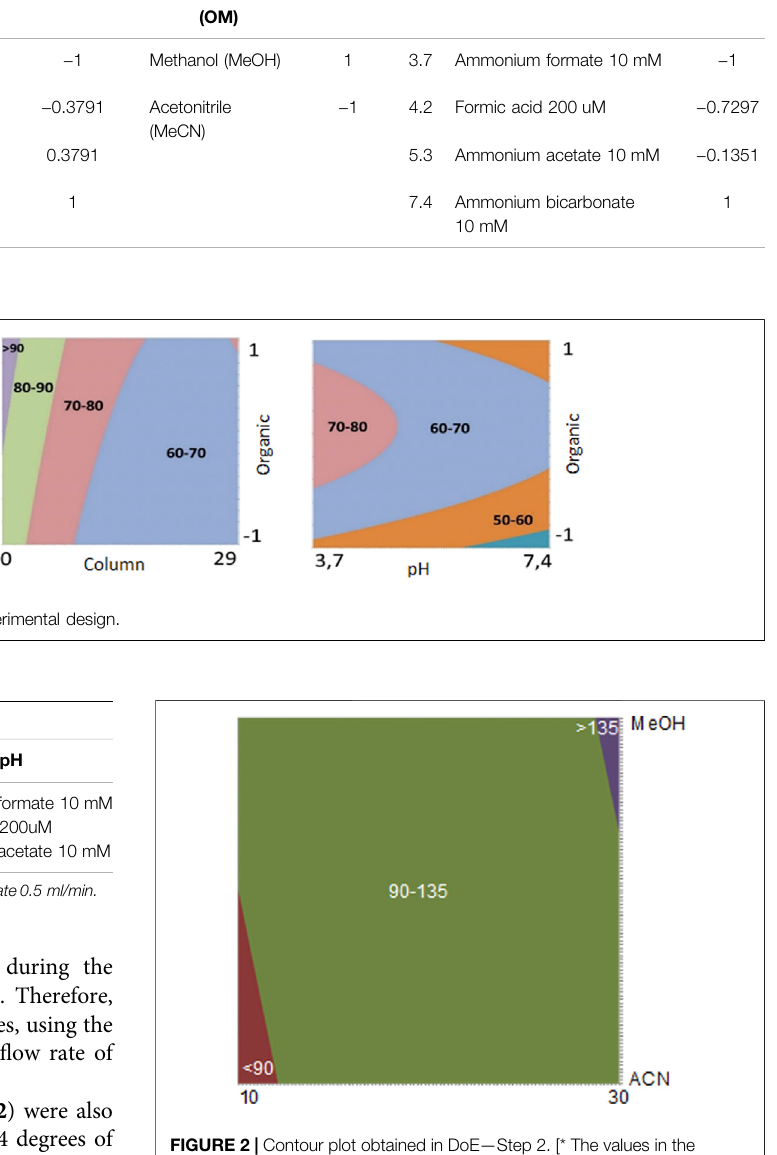
FIGURE 2 | Contour plot obtained in DoE — Step 2. [* The values in the contour chart refer to the number of chromatographic bands. ** Fixed condition: Kinetex ® Biphenyl column, pH 4.2 (formic acid 200 μ M), temperature40 ° C,and fl owrate0.5 ml/minXaxis(time — minutes)andY axis organic modi fi